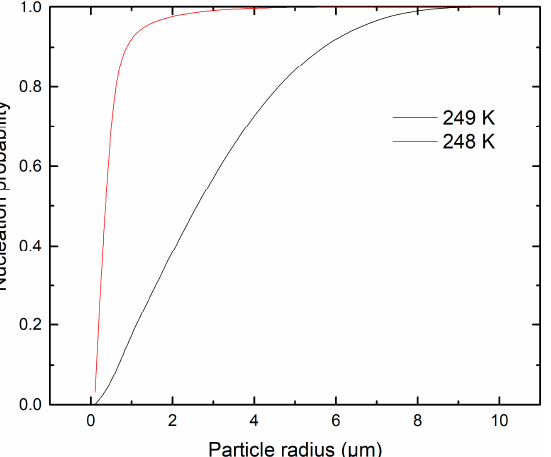
Figure 7. Nucleation probability versus particle radius of the pre-existing particle at an altitude of 6 6 km (T = 248–249 K, contact angle θ = 55 km (T = 248– 249 K, contact angle θ = 55 degrees).